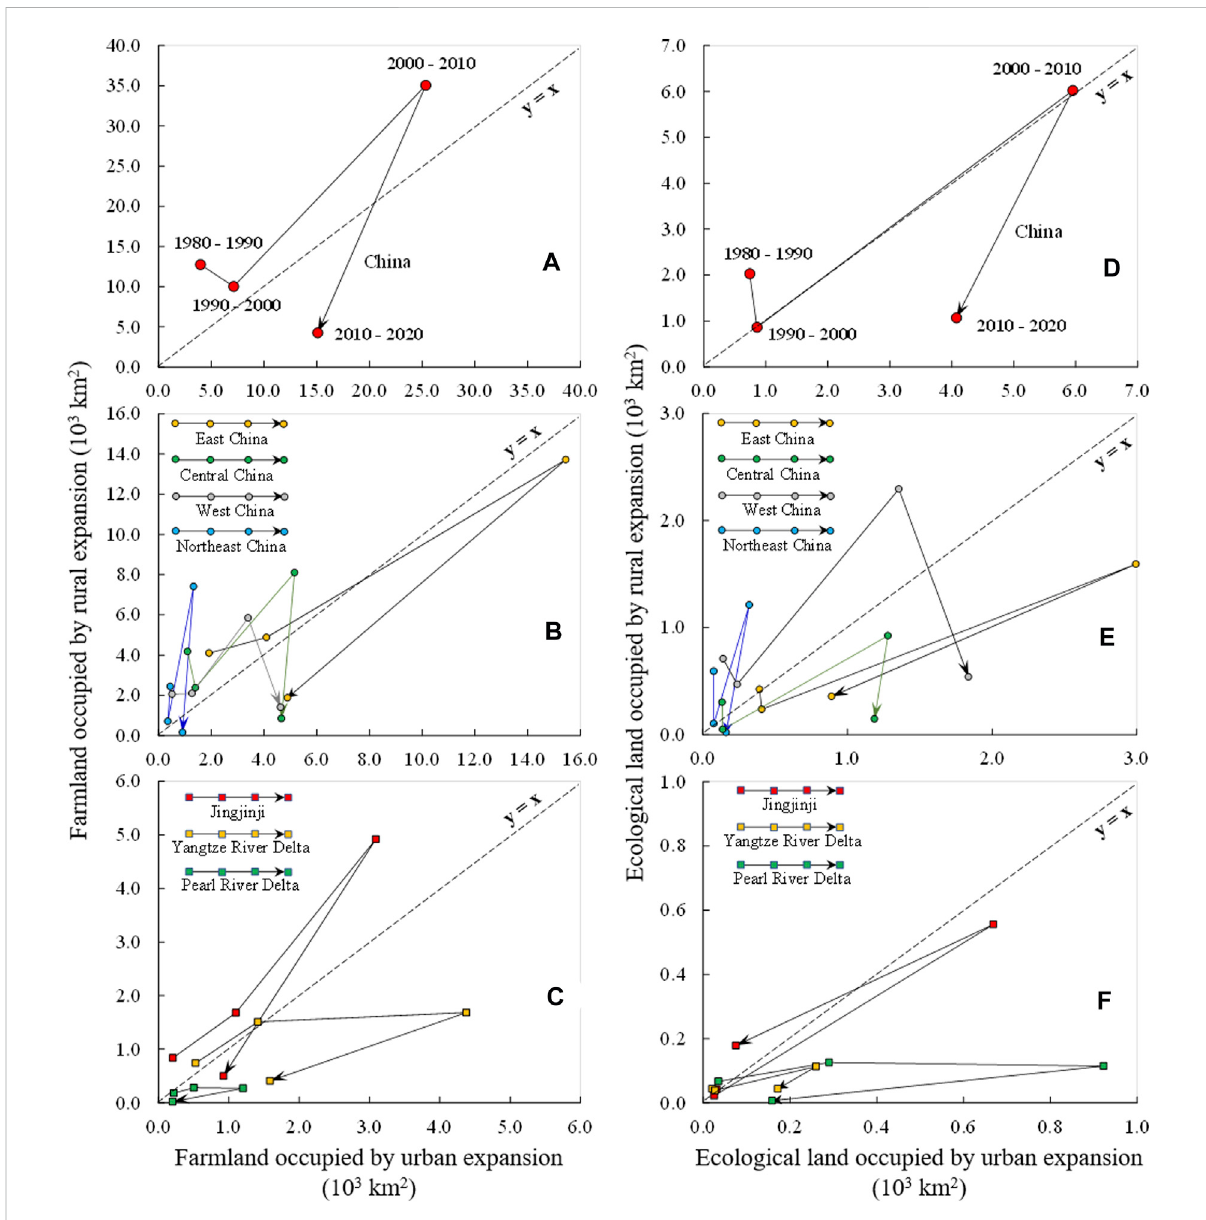
FIGURE 4 Farmland and ecological land occupied by urban and rural expansions in China during 1980 – 2020. (A,D) show farmland and ecological land occupationinChina,respectively; (B,E) showfarmlandandecologicallandoccupationinsubregionsofChina,respectively; (C,F) showfarmlandand ecological land occupation in China ’ s three urban developing hot-spots,